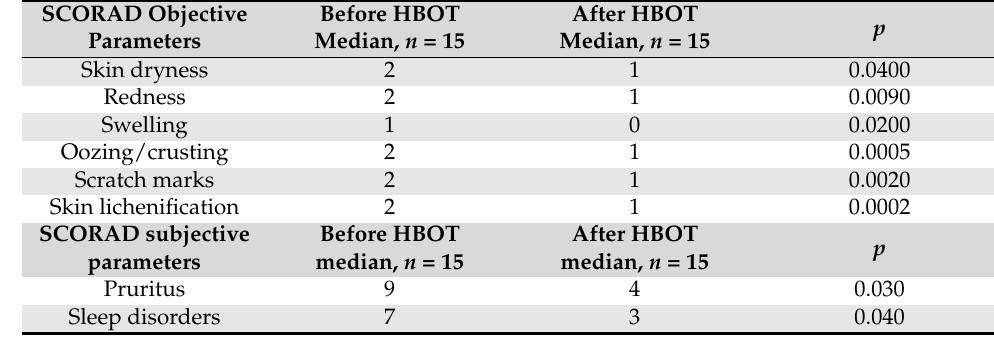
Table 3. Effect of the HBOT on the skin’s clinical condition (0–3 scale), the intensity of pruritus and sleep disorders (median, numeric scale: 0–10 points), p < 0.05. SCORAD Objective Before HBOT Parameters Median, n = 15